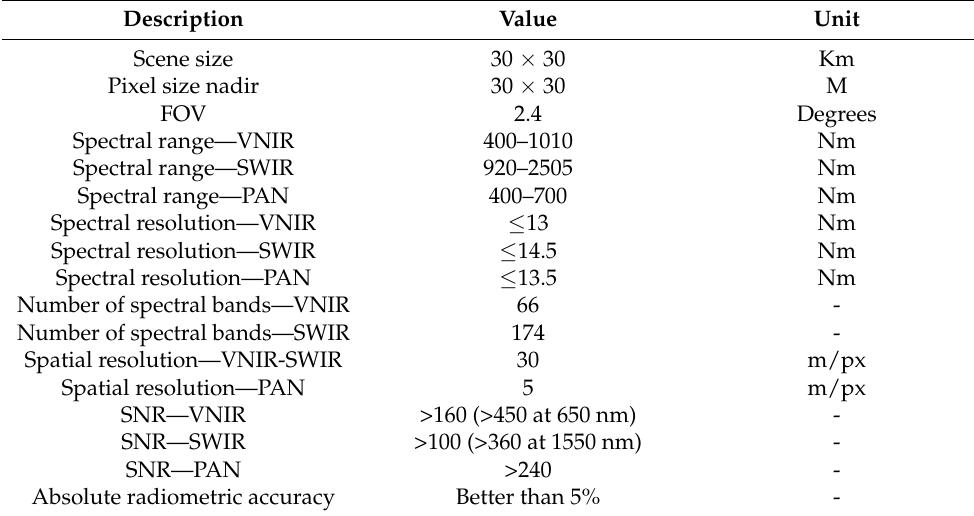
Table 1. PRISMA instrument characteristics